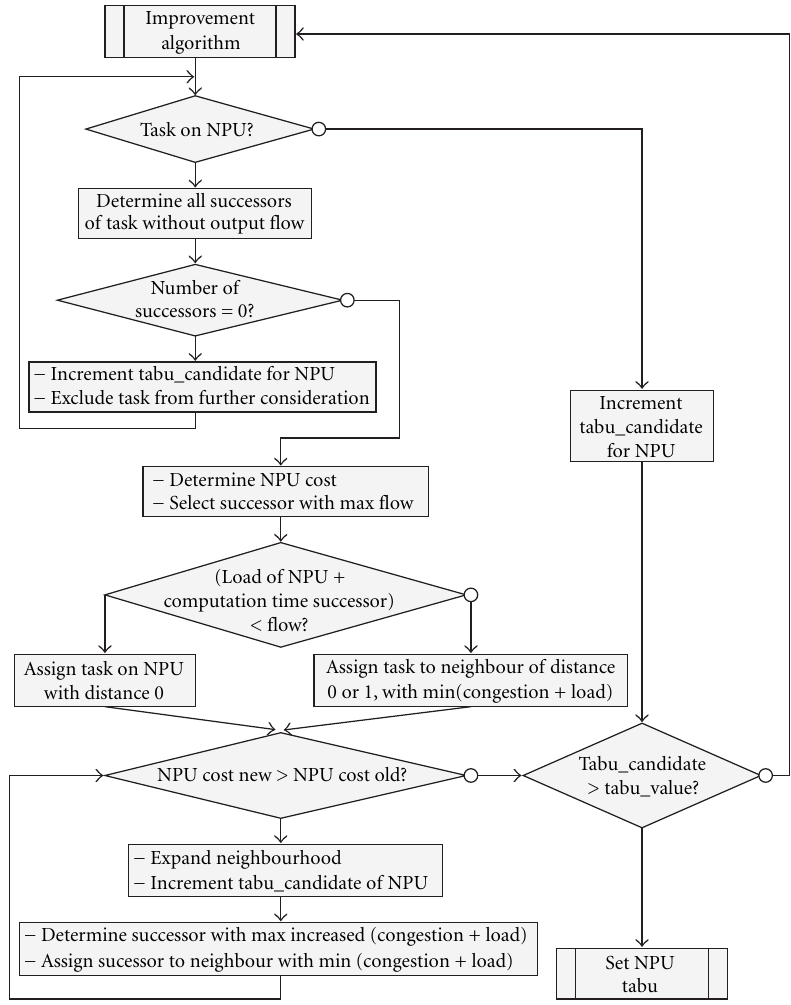
Figure 6: Program flow: improvement